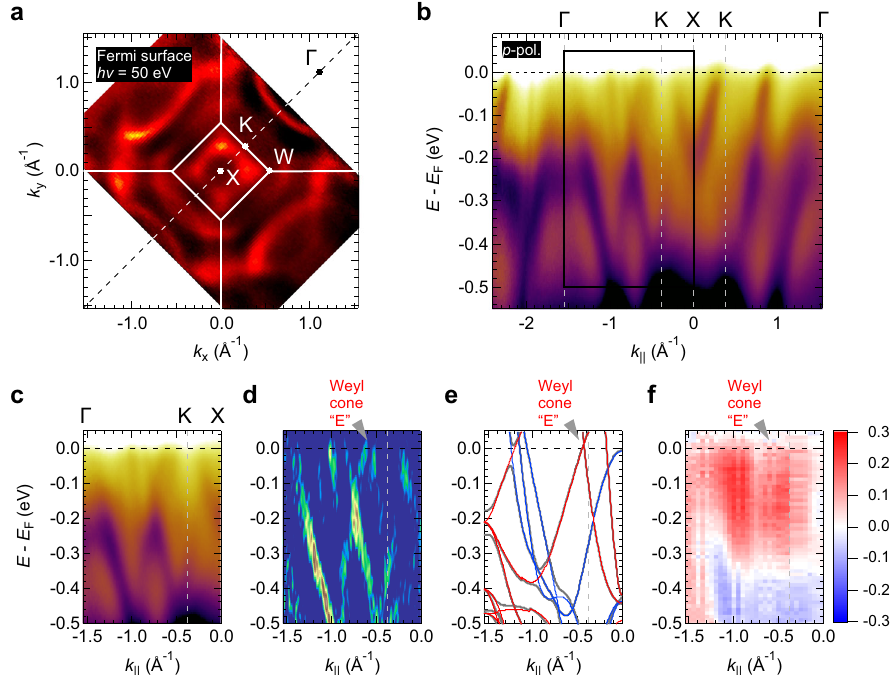
Fig. 5 Observed spin-polarized band structures of a hole-doped Co 2 MnGa fi lm. a Fermi surface of the sample H3* ( N v = 27.3) recorded at 50 eV with p - polarized light. b Wide ARPES image along the Γ – K – X line indicated by the white dashed line in a . c , d Magni fi ed ARPES image in the frame in b and its second derivative. e Calculated band dispersion with E F shifted downward by 220meV. f Spin-polarization map along the Γ – K – X